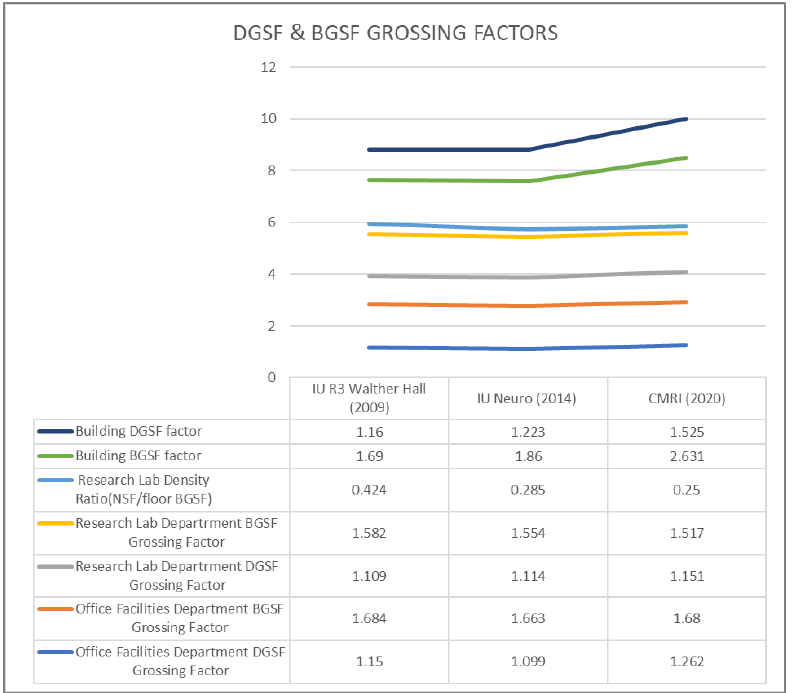
Figure 5 Departmental NSF, DGSF, and BGSF